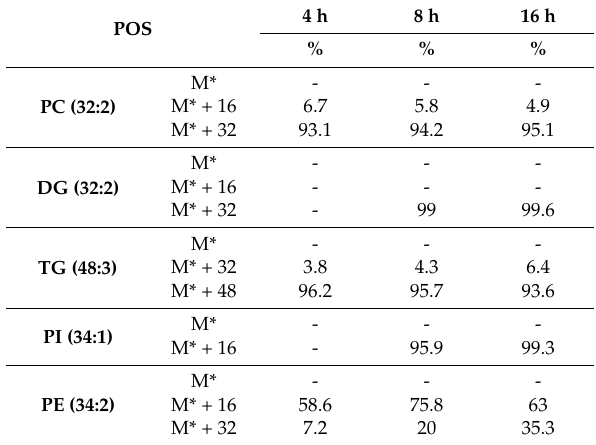
Table 2. Stable isotope-labeled metabolites in 13 C16-palmitoleic acid-treated ( 13 C16:1) HepG2